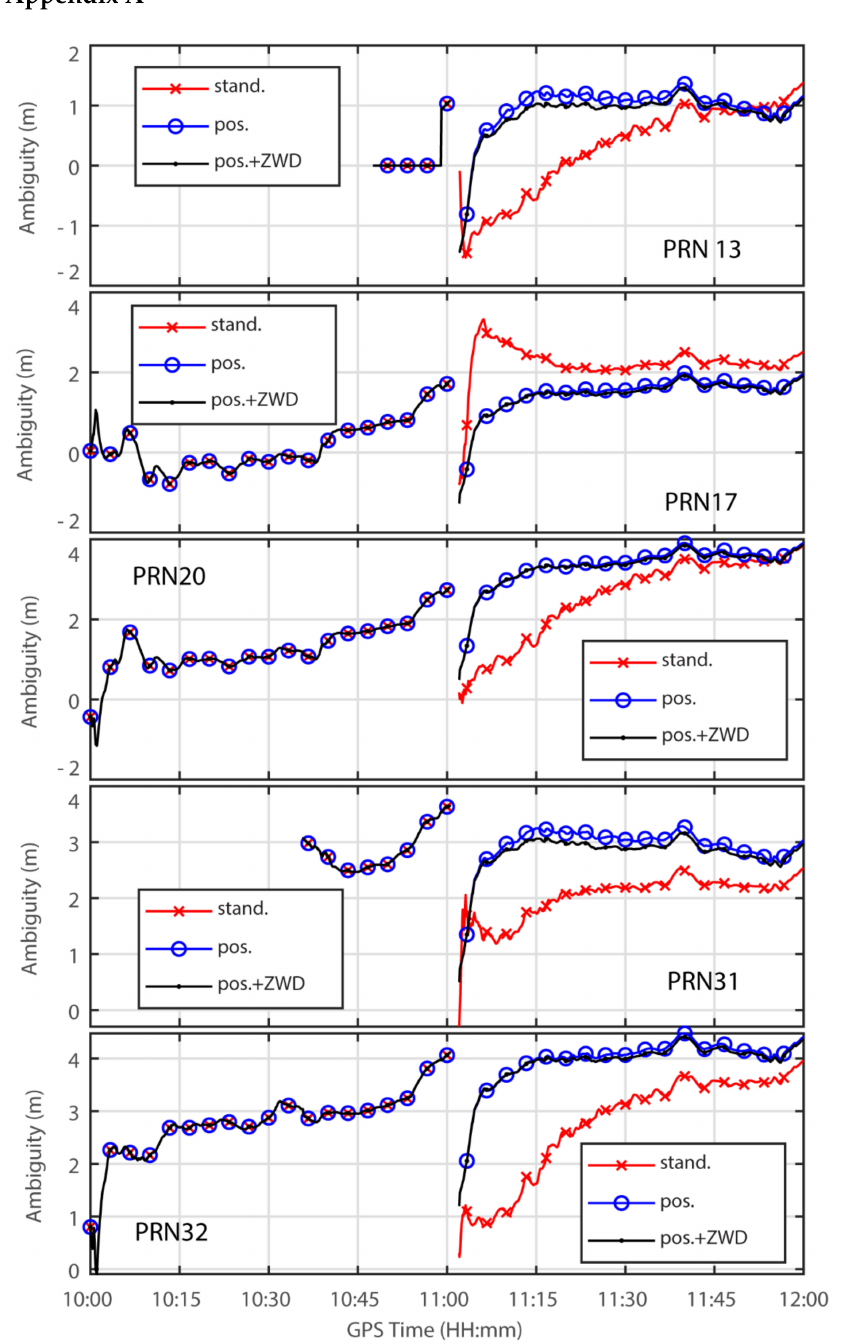
Figure A1. Zero differenced carrier phase bias solution of GPS PRN13, PRN17, PRN 20, PRN31 and PRN 32 from standard PPP and constrained PPP over 2